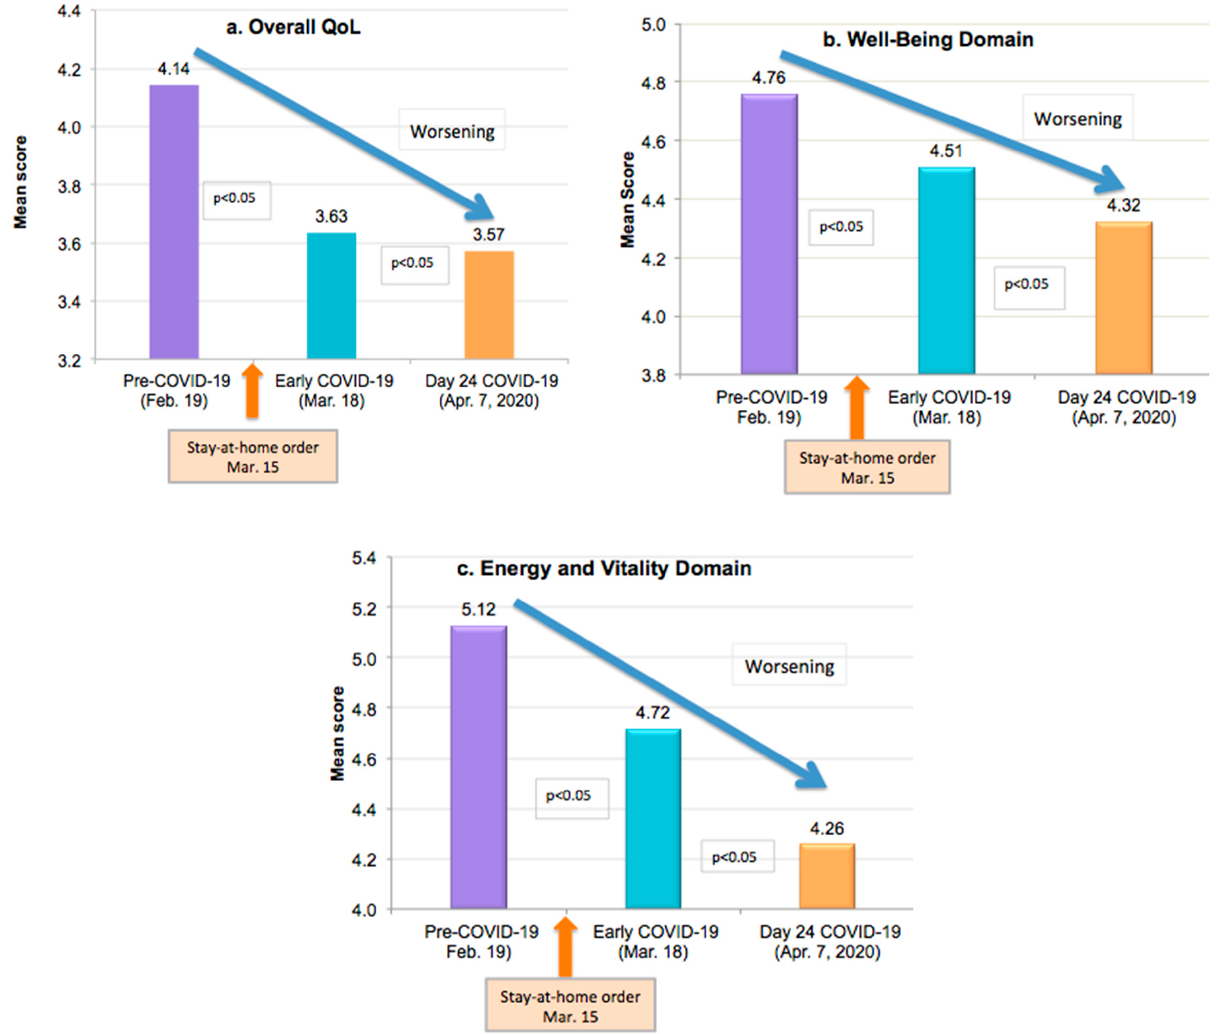
Figure 5. Effect of COVID-19 Confinement on QoL. The study was conducted among 63 healthy women aged 23–54 years old. Responses to the FQoL™ were collected prior to the 2020 pandemic stay-at-home orders (19 February), 3 days after the 15 March stay-at-home orders (18 March), and 24 days after the stay-at-home orders (7 April). Mean scores for the overall QoL ( a ), the Well-Being Domain ( b ), and the Energy and Vitality Domain ( c ) are presented. The subdomains and domains were averages of responses to individual items within that grouping, and means were. evaluated using a paired t -test. The 2-sided p values are reported. All analyses were done using JMP Pro version 14.2.0 and SAS 9.4 (Baiyang Wang-Statistician).